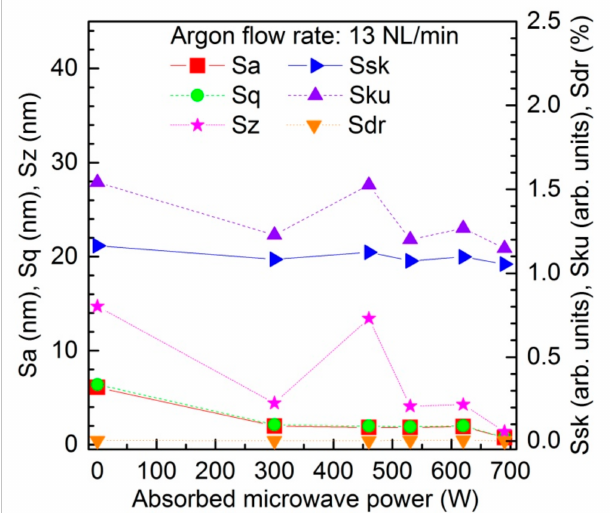
Figure 5. E ff ect of the microwave power on the roughness parameters (Sa, Sq, Sz, Ssk, Sku, Sdr) of the polycarbonate sample. Argon flow rate 13 NL /